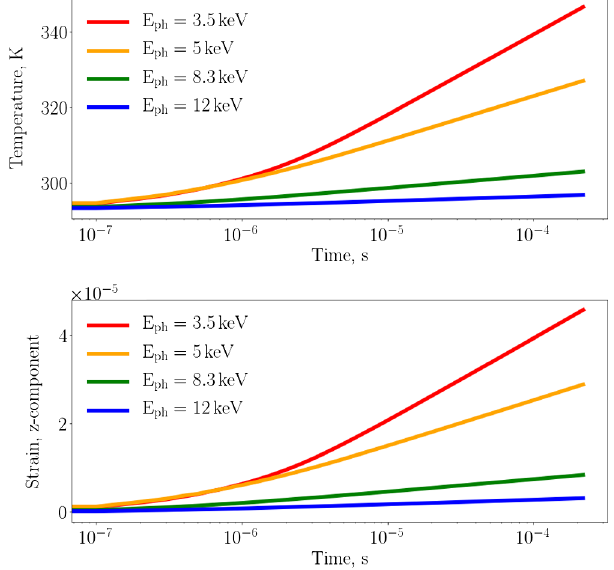
FIG. 6. Temperature (top) and strain (bottom) in the center of the Gaussian beam profile as a function of time calculated for four different photon energies. Calculations are done for the quasi- continuous exposure